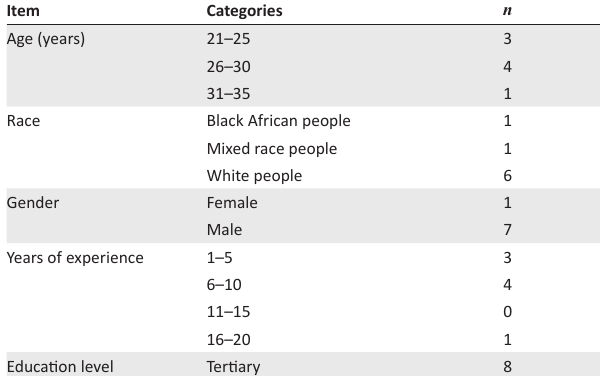
TABLE 1: Demographics of the study participants ( N =